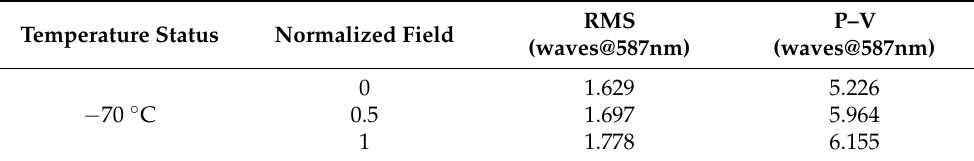
Figure 7. Field curves graphs of the athermal visible lens at − 70 °C considering thermal-induced surface deformation. Table 4. Wavefront analysis results of the athermal visible lens at − 70 ◦ C considering thermal- induced surface